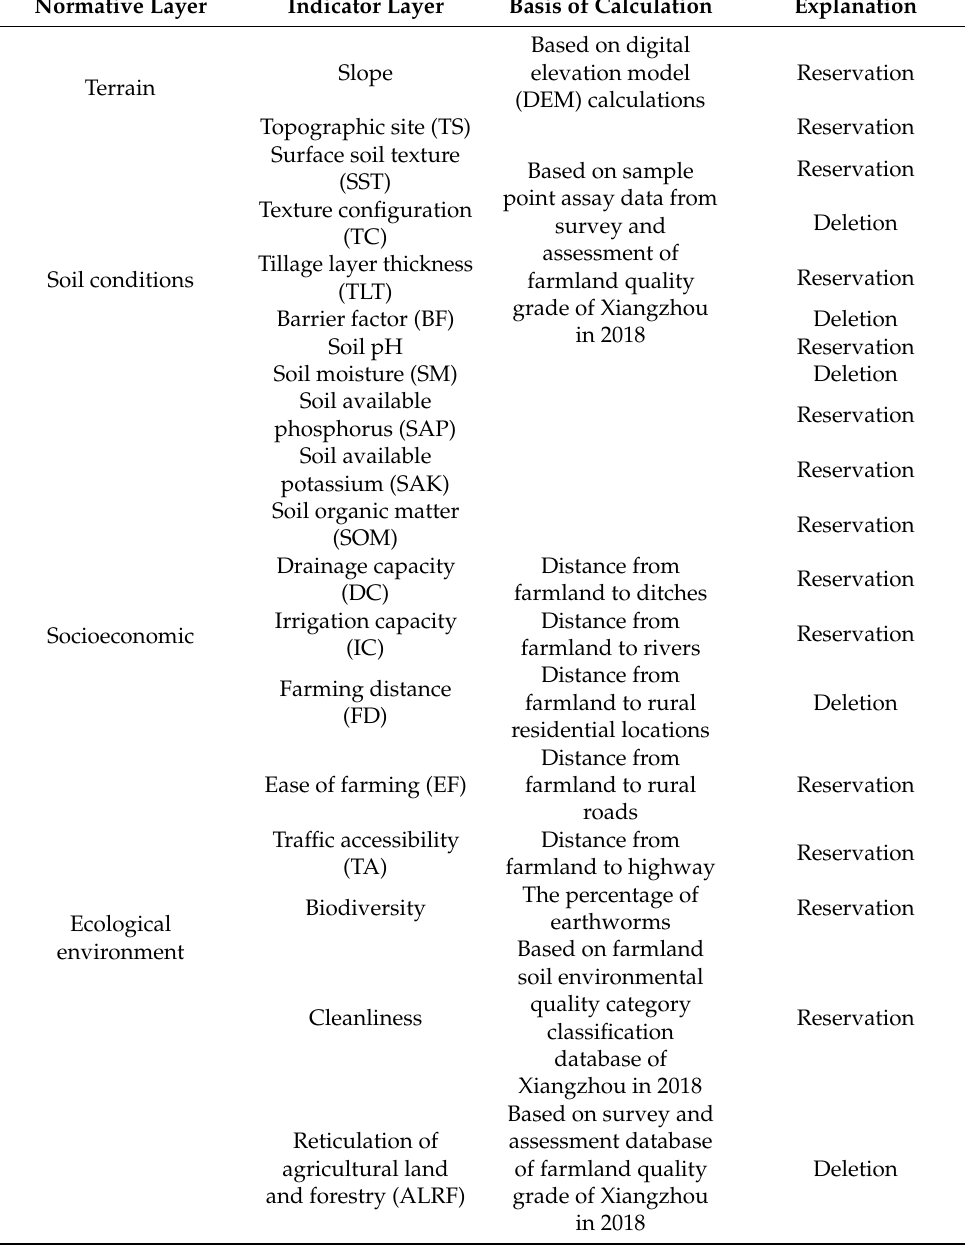
Table 1. System of indicators for evaluating the quality of